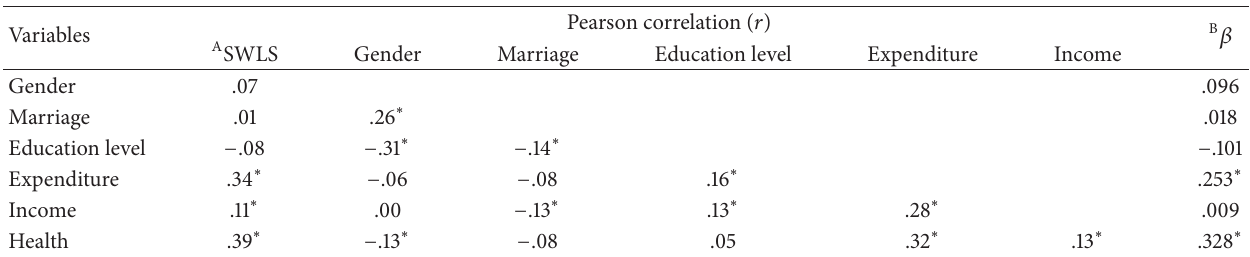
Table 5: Correlations and results from regression analyses of AFC scores in association with SWLS score in young-old participants. Outdoor A SWLS spaces